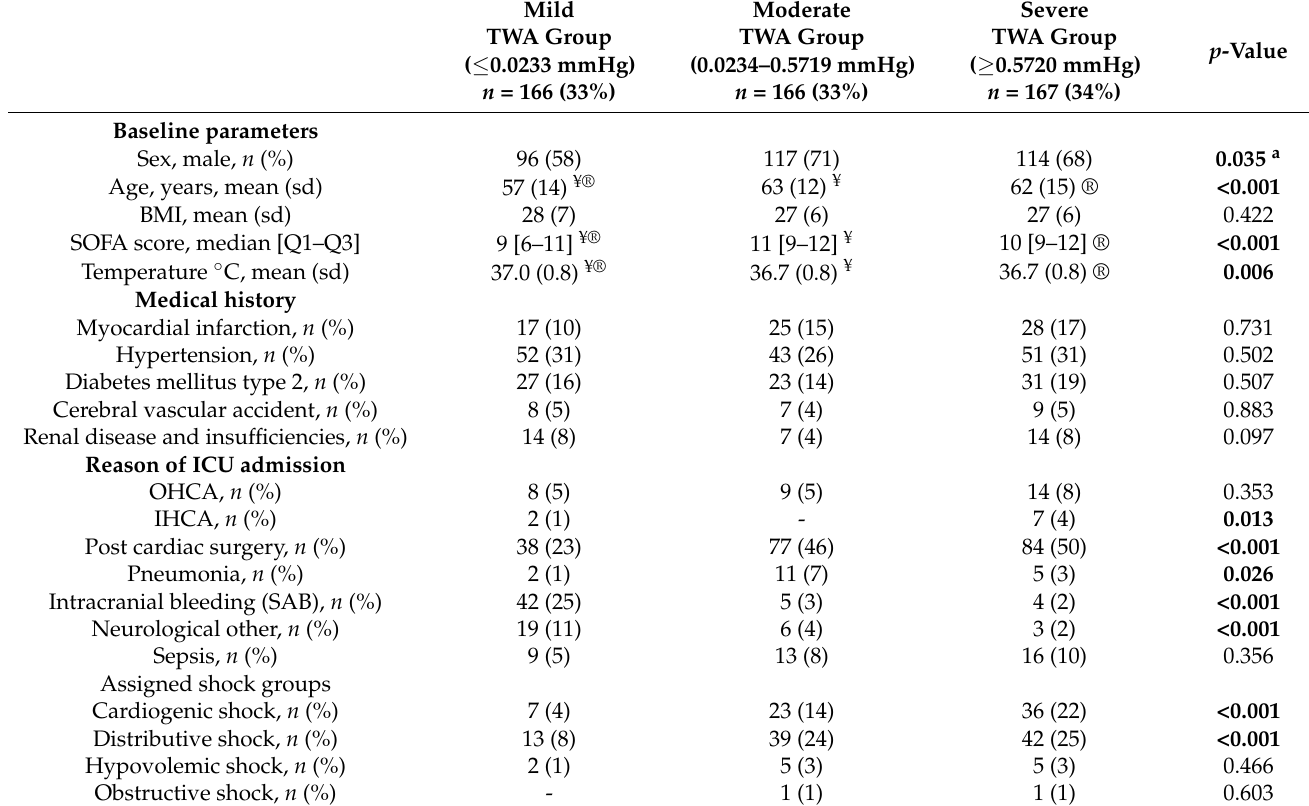
Table 3. Subgroups of hypotension based on time-weighted